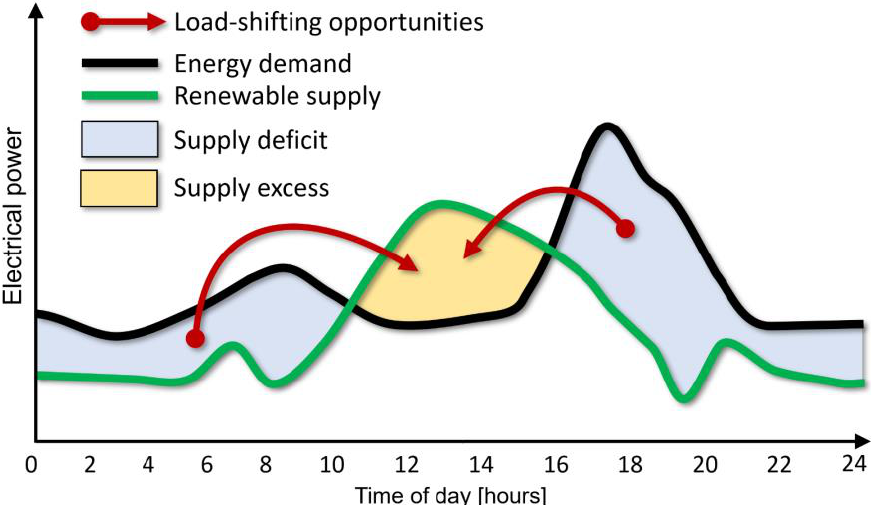
Figure 2. Typical daily renewable supply and demand profiles, and load-shifting opportunities.